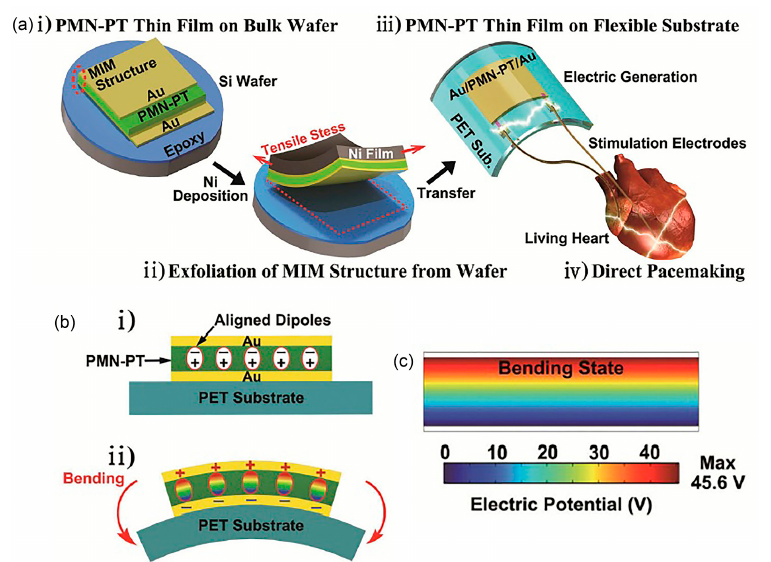
Figure 11. Twelve groups of 10 MEHs clamped on a bending stage in ( a ) flat and ( b ) bent configu- ration. ( c ) The PZT/PI MEHs device is connected and integrated with a rectifier and rechargeable microbattery. ( d ) The integrated MEHs is attached onto the right ventricle of bovine heart during (i) expansion and (ii) relaxation. ( e ) The illustration of a multilayer stack of five PZT/PI MEHs sheets connected in series and the equivalent schematic circuit [70].